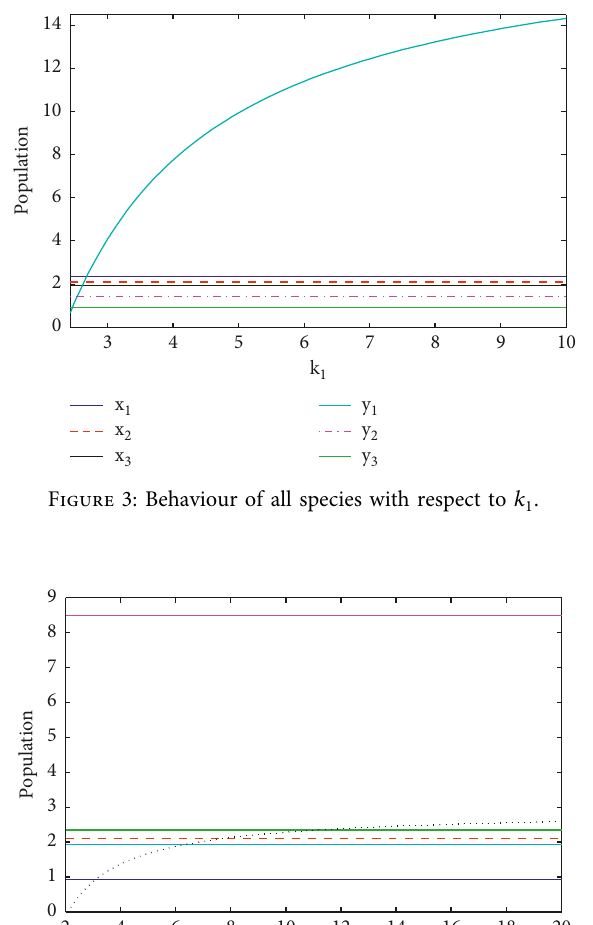
Figure 4: Behaviour of all species with respect to k